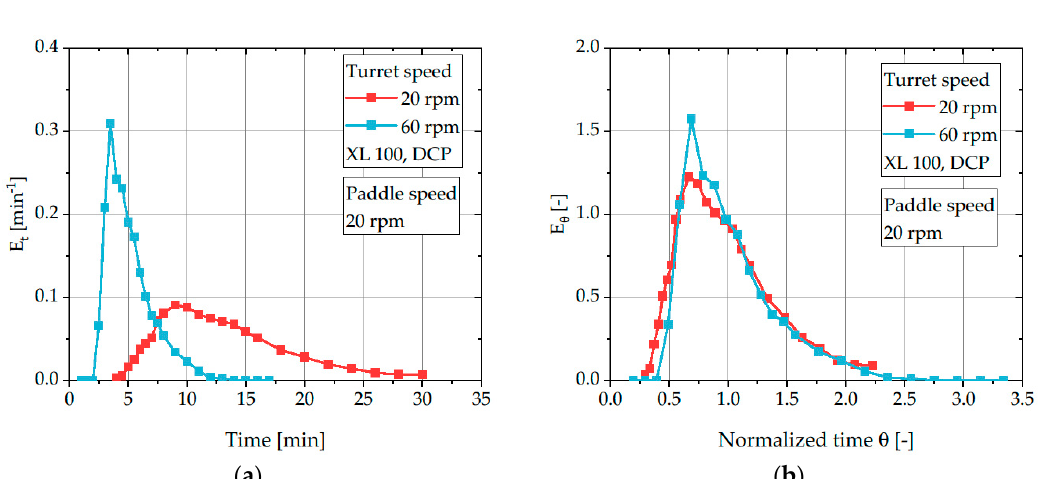
Figure 3. Residence time distribution E t ( a ) and normalized residence time distribution E θ ( b ) for different turret speeds using DCP as a tracer and bulk powder at the XL 100.